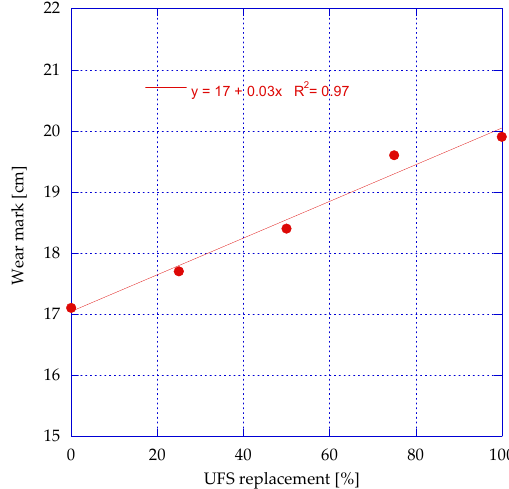
Figure 18. Wear Figure 18. Wear resistance.